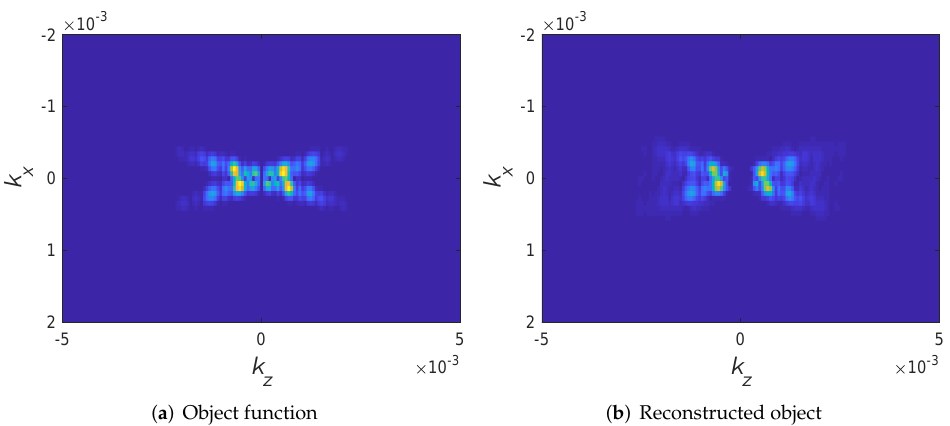
Figure 9. Example A: Comparison of the K − space distributions of the original ( a ) and reconstructed ( b )